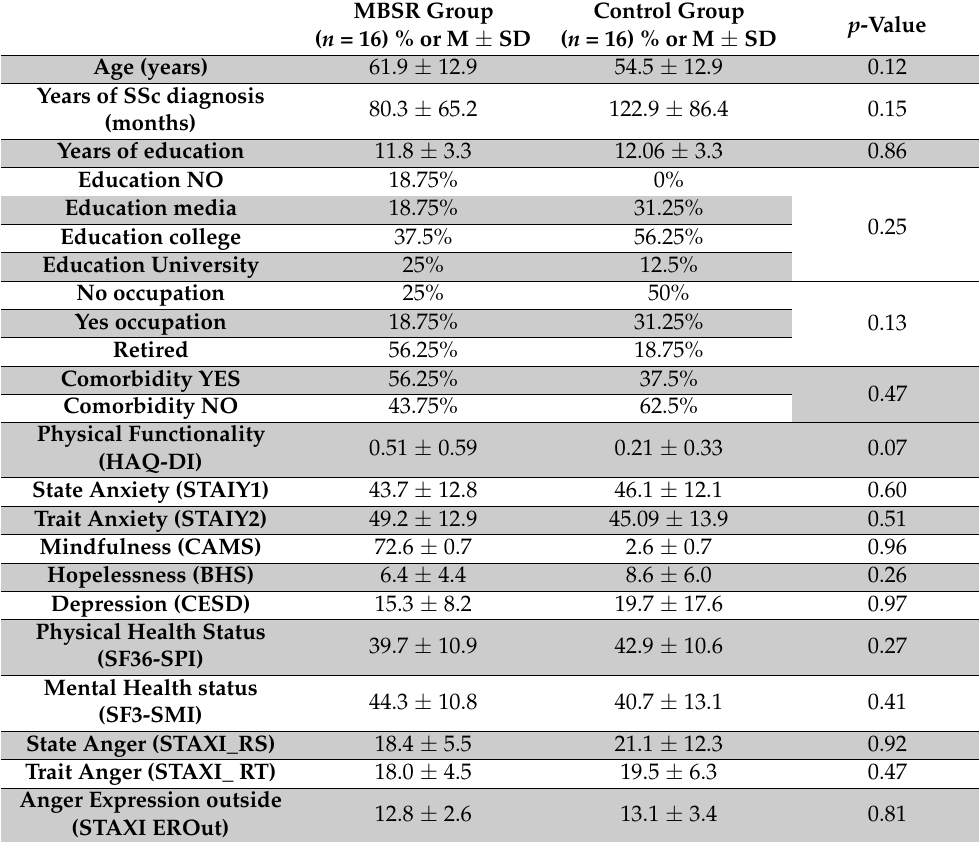
Table 1. Baseline descriptive characteristics on age, years of SSc diagnosis, education, occupation and clinometric variables of the study participants in the MBSR program (control and experimental groups) and differences between